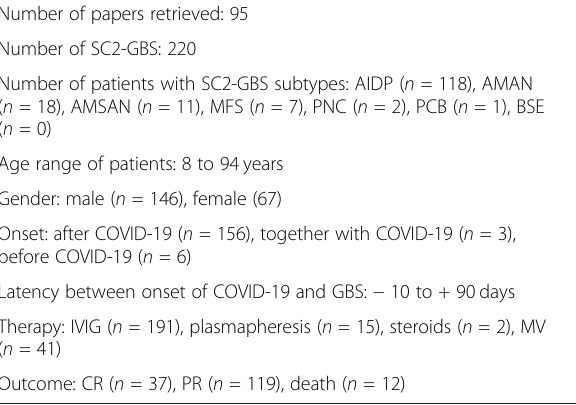
Table 2 Summary of findings in 220 patients with SC2-GBS Number of papers retrieved: